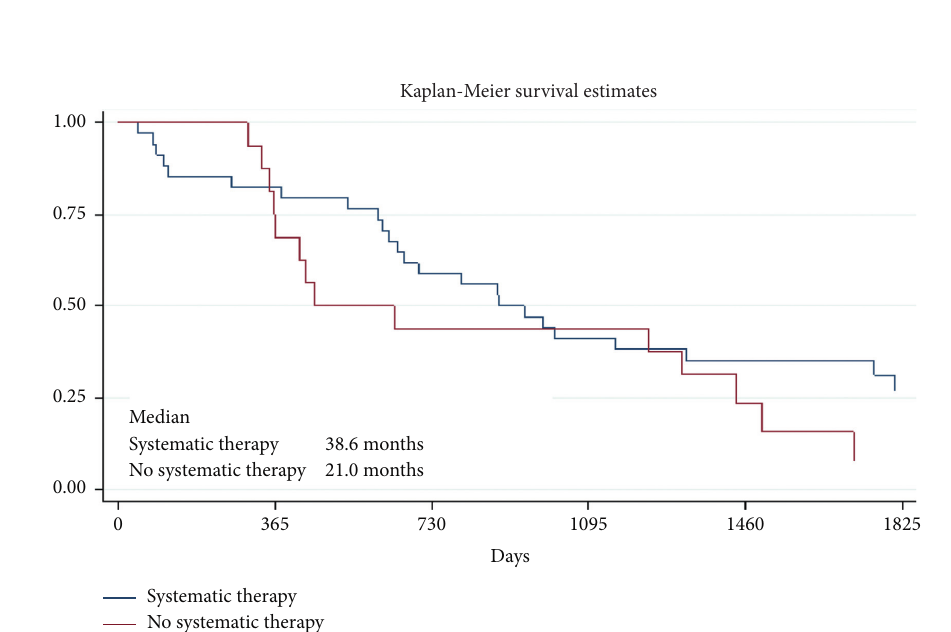
Figure 4: Survival results of the patient treated by systemic therapy ( p � 0 .